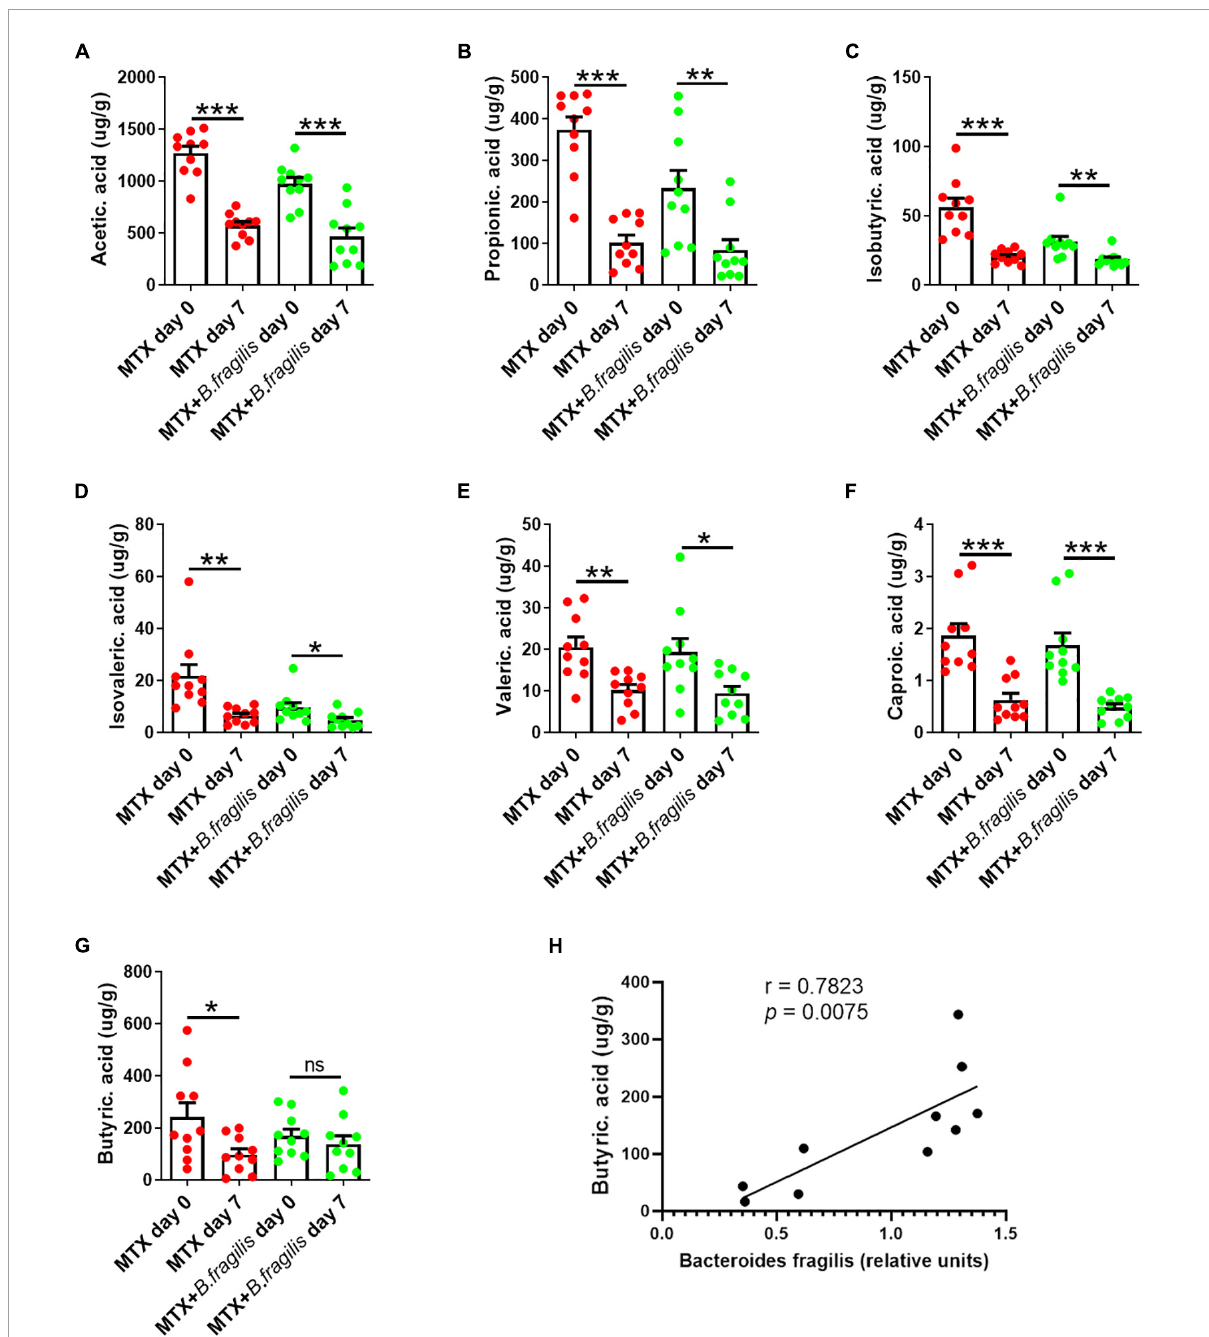
FIGURE4 Analysis of SCFAs in feces of mice. MTX-treated CIA mice were gavaged with PBS or PBS containing B. fragilis for 7 days. Fecal samples were collected for GC-MS analysis of (A) acetic acid, (B) propionic acid, (C) isobutyric acid, (D) isovaleric acid, (E) valeric acid, (F) caproic acid and (G) butyric acid (butyrate), ( n = 10). (H) Correlation analysis between and the relative units of B. fragilis and the content of butyrate. Data are presented as the mean ± SEM. * p < 0.05, ** p < 0.01, *** p <